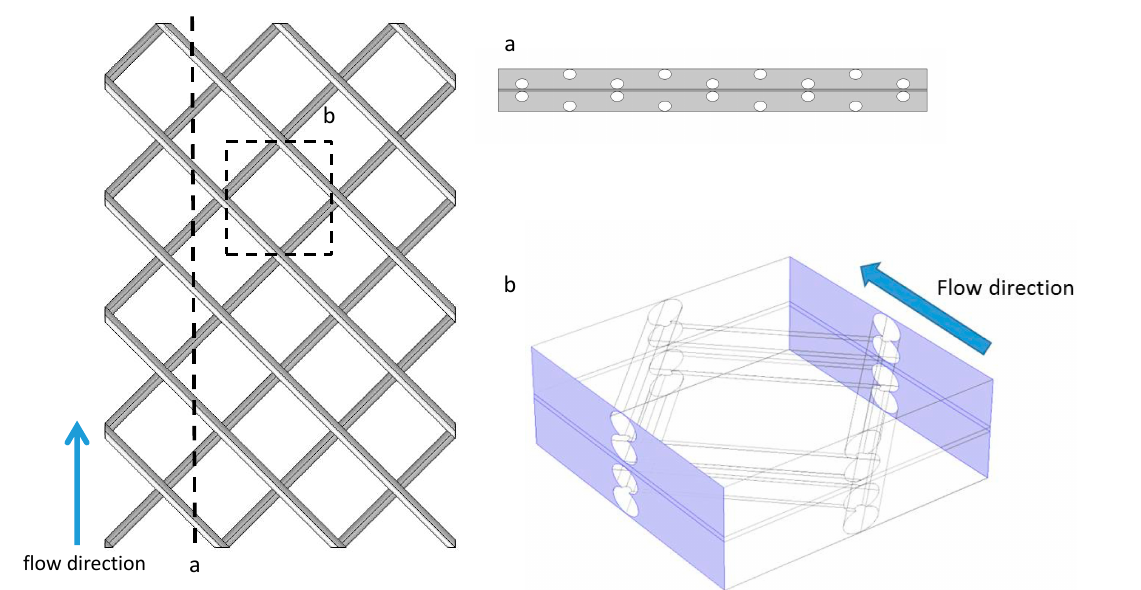
Figure 2. 3D illustration of the mesh spacer ( left ). The dashed line indicates the location of the 2D model ( a , top right). The dashed lined square indicates the location of the 3D model ( b , bottom right). The location of periodic boundaries is marked in purple.